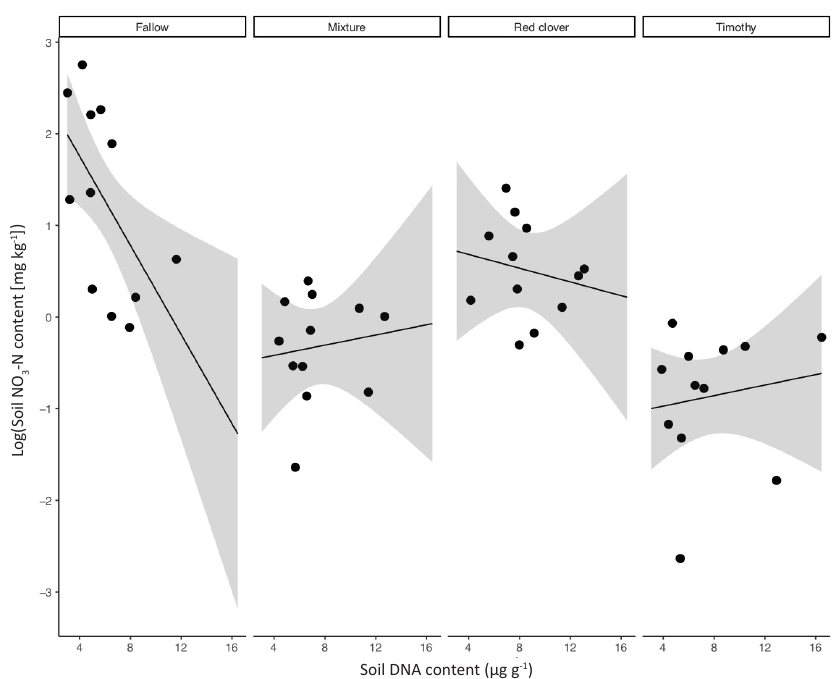
Soil DNA content (µg g -1 -N content. The grey areas 3